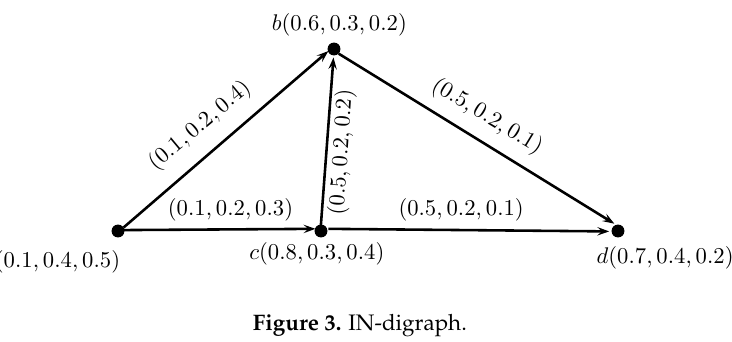
Figure 3. IN-digraph.